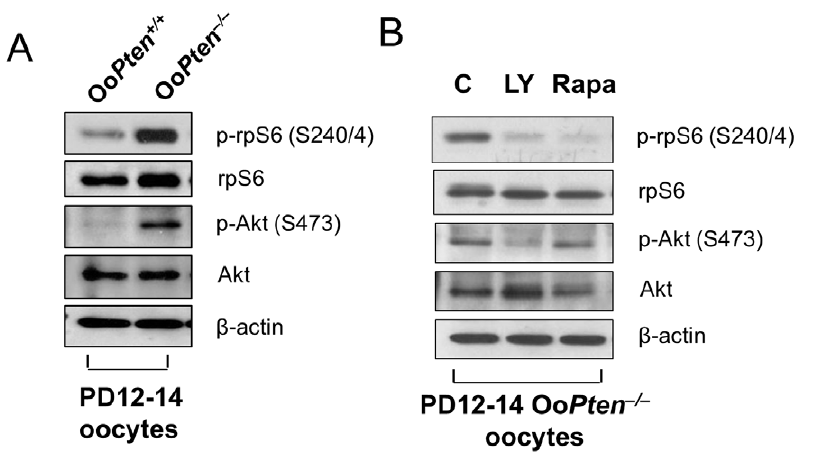
Figure 1. Enhanced Akt-rpS6 activation and invitro inhibition of rpS6 activation in Oo Pten 2 / 2 oocytes by rapamycin. ( A ) Comparison of Akt-rpS6 signaling in Oo Pten 2 / 2 and Oo Pten + / + oocytes. Oocytes were isolated from ovaries of mice at postnatal day 12–14 and immunoblotting was performed as described in Materials and Methods . Loss of PTEN led to enhanced PI3K signaling as indicated by an increase in phosphorylated Akt (p-Akt). The level of phosphorylated rpS6 (p-rpS6) was also increased in Oo Pten 2 / 2 oocytes compared with Oo Pten + / + oocytes. Levels of total rpS6, Akt, and b -actin were used as internal controls. ( B ) Activation of rpS6 in Oo Pten 2 / 2 oocytes is dependent on mTORC1 signaling. Oocytes were isolated from ovaries of Oo Pten 2 / 2 mice at PD 12–14 as described in Materials and Methods . Treatment of oocytes with the mTORC1-specific inhibitor rapamycin (Rapa, 50 nM) for 2 h was found to largely suppress levels of phosphorylated rpS6 (p-rpS6), but did not affect the level of phosphorylated Akt (p-Akt). As a control, treatment of Oo Pten 2 / 2 oocytes with the PI3K-specific inhibitor LY294002 (LY, 50 m M) for 2 h also largely suppressed levels of phosphorylated rpS6 (p-rpS6), but it also suppressed the level of phosphorylated Akt (p-Akt). This suggests that activation of rpS6 in Oo Pten 2 / 2 oocytes is dependent on both PI3K and mTORC1 signaling. Levels of total Akt, rpS6, and b -actin were used as internal